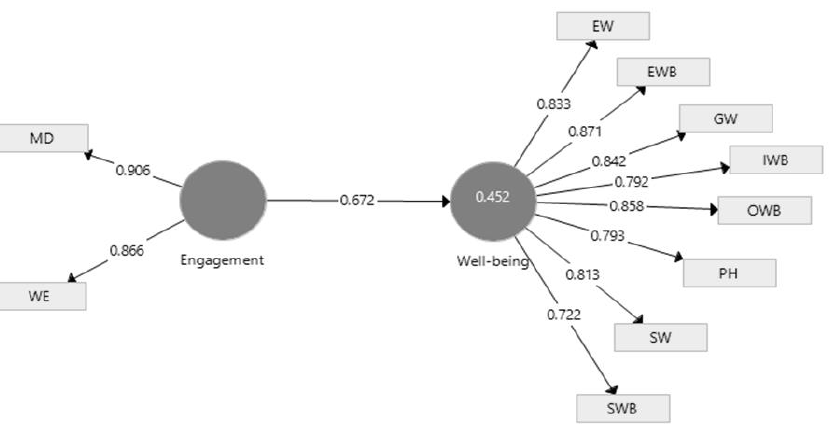
Figure 4. The model obtained using a selected sample. Source: Developed by authors using SmartPLS v3.0 (SmartPLS GmbH, Oststeinbek, Germany).